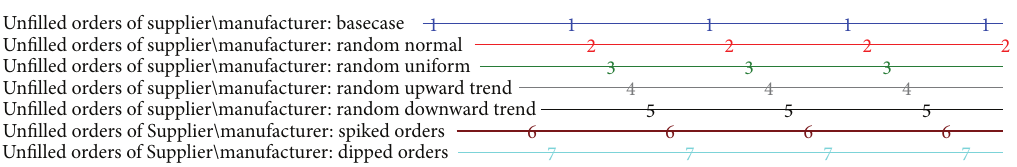
Figure 5: Unfilled orders at supplier/manufacturer despite information visibility and flexible work week policies.